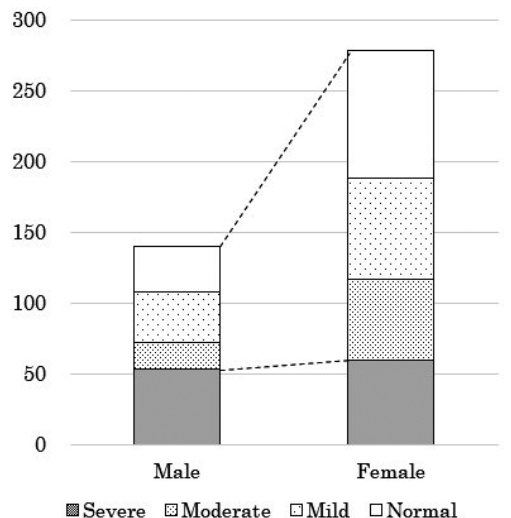
Figure 2. Severity of taste disorders by sex. The overall male–female ratio of taste disorder patients was 1:2. predominance of females was due to a large number of normal- moderate female